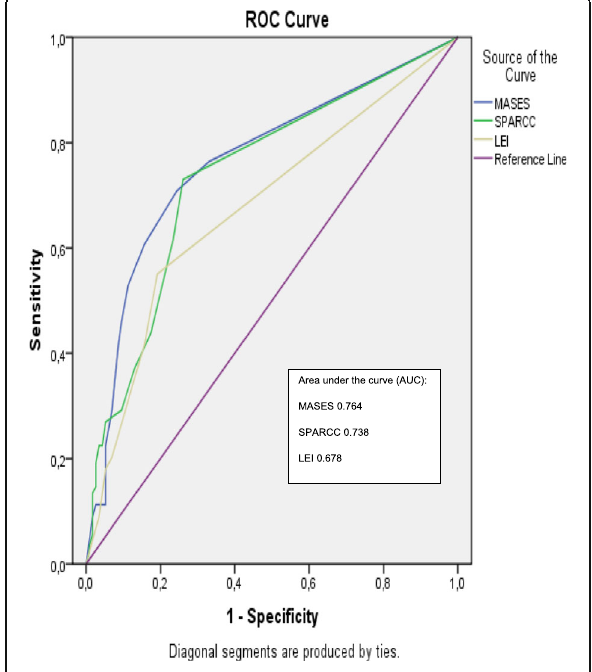
Fig. 1 Performance of MASES, SPARCC and LEI in axial SpA to discriminate between active disease (BASDAI ≥ 4) and inactive disease (BASDAI <